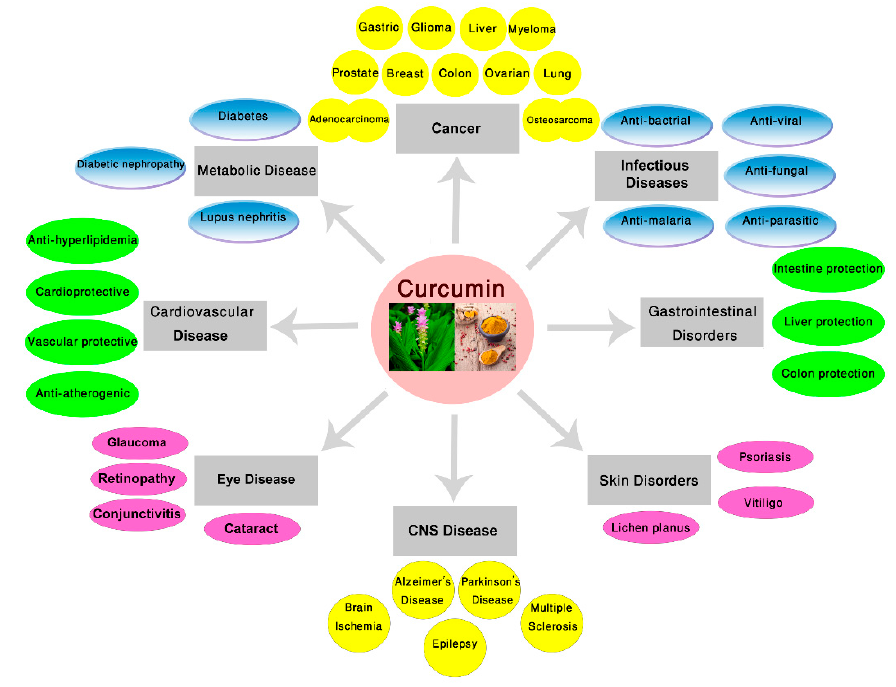
Figure 1. Effect of curcumin in different diseases. The therapeutic benefits obtained from in vitro cell cultures to small and large animal studies as well as clinical trials. CNS: Central Nervous System.